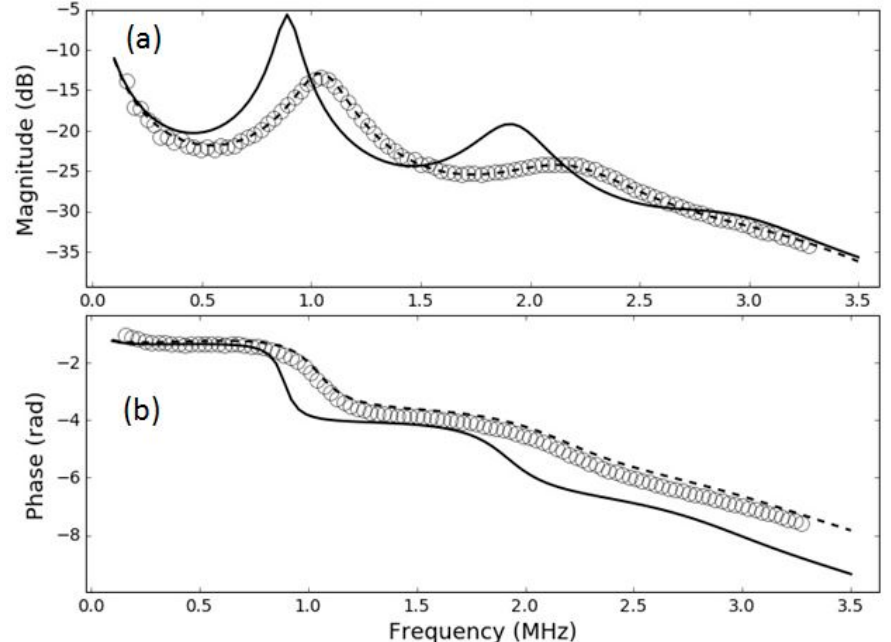
Figure 12. Magnitude ( a ) and phase ( b ) spectra of the transmission coefficient of the HS06 film in water immersion at normal incidence. Open circles: experimental data. Solid line: calculated response using film parameters obtained in [42]. Dashed line: calculated response using film parameters extracted from water immersion measurements.